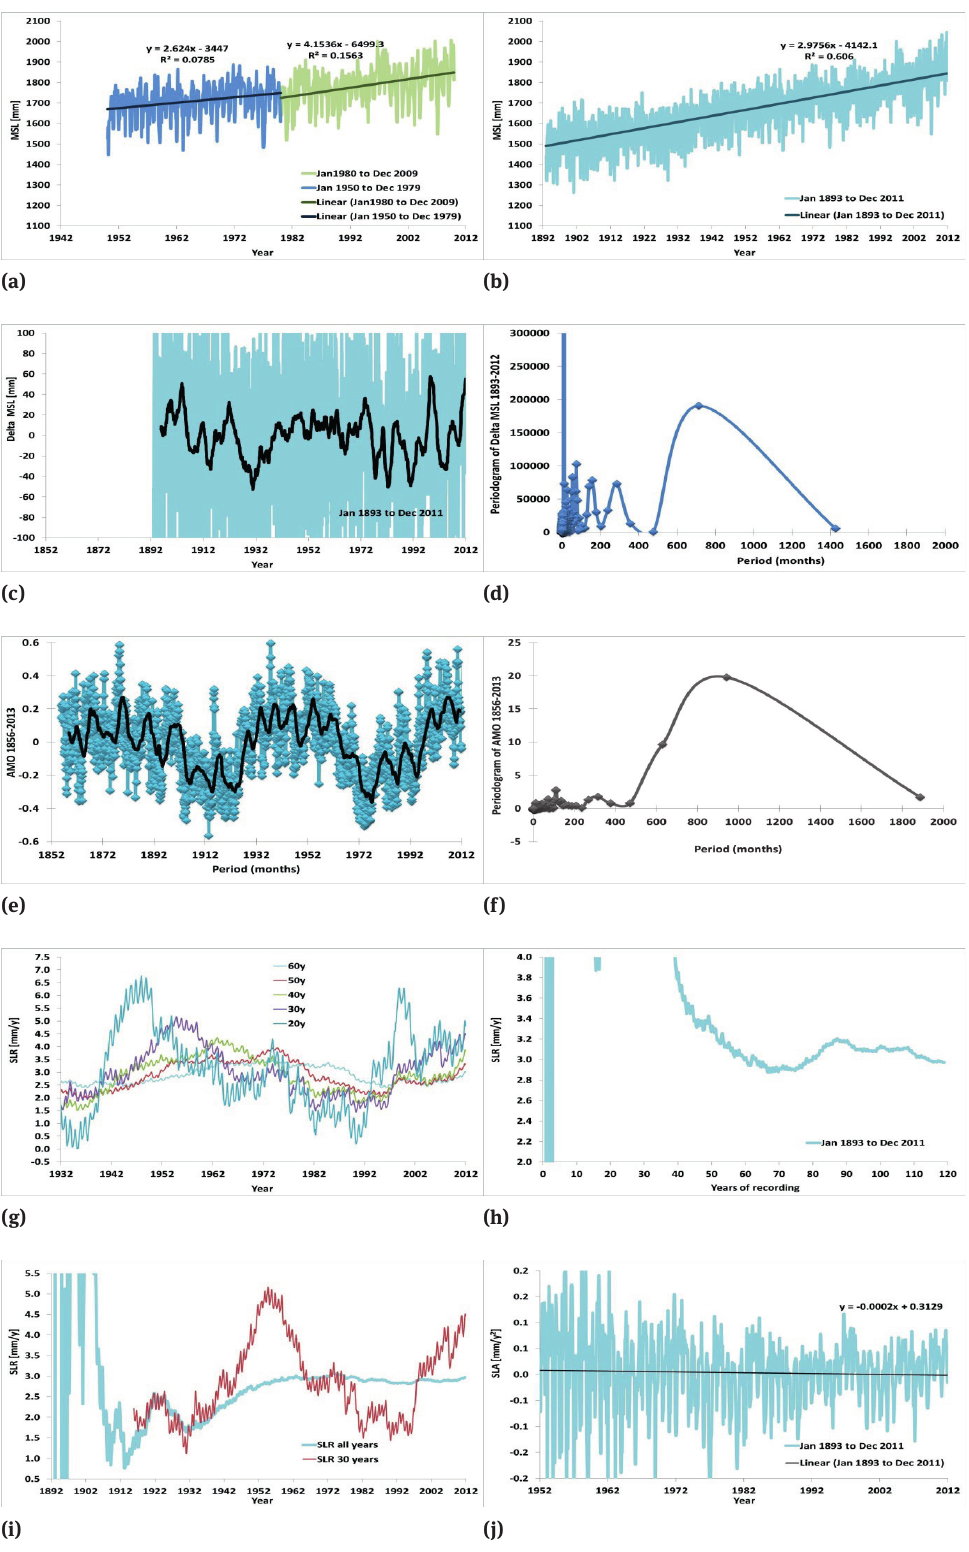
Fig. 3. The Battery, NY tide gauge: a) unrealistic sea level rate of rise computed with a 30 years time window. b) sea level rate of rise com- puted with 120 years of data. c) oscillations about the linear trend. d) periodogram of these oscillations. AMO: e) index. f) periodogram. The Battery, NY tide gauge: g) time history of the rates of rise of sea level computed by using different time windows of 20, 30, 40, 50 and 60 years at any time. h) present rate of rise of sea levels computed by using different record length. i) time hystory of the rates of rise of sea level computed by using all the data available at a certain time and 30 years. j) time rate of change of the latter sealevel rate of